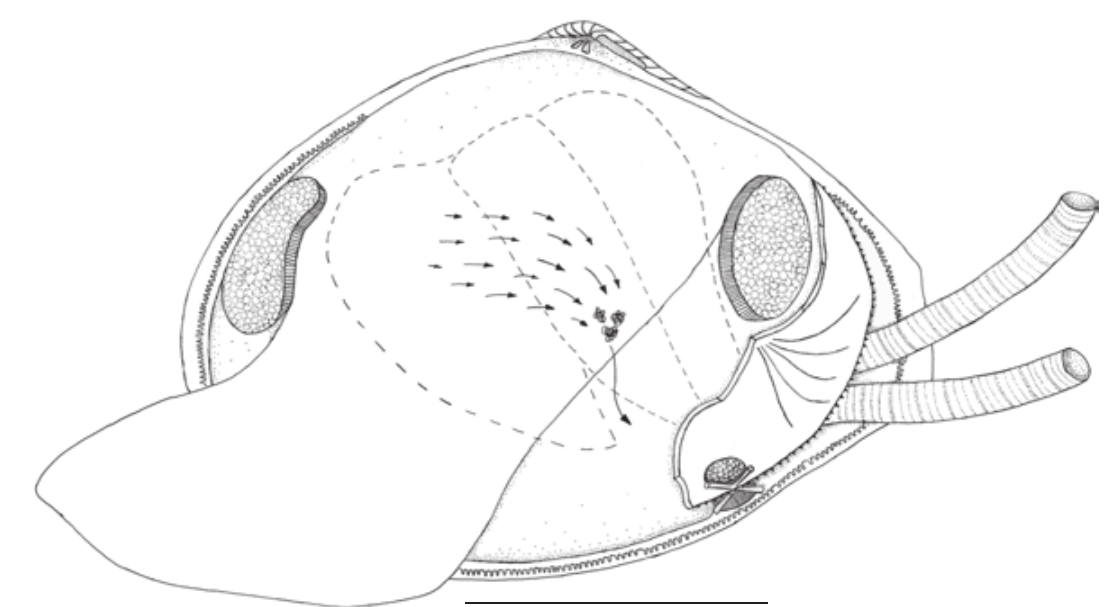
Figure 7. Macoma biota : ciliary currents on the proximal region of the foot’s epithelium that holds the visceral mass. The left ctenidium and labial palps were removed and the dashed lines indicates their original position in the live animal. Scale bar: 1.5 cm.